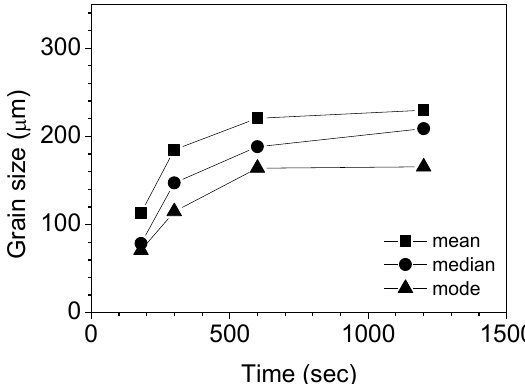
Figure 4. Grain size as a function of annealing time for SS400 with 1.5 ppm Mg at 1200 °C using the mean, median, and mode.